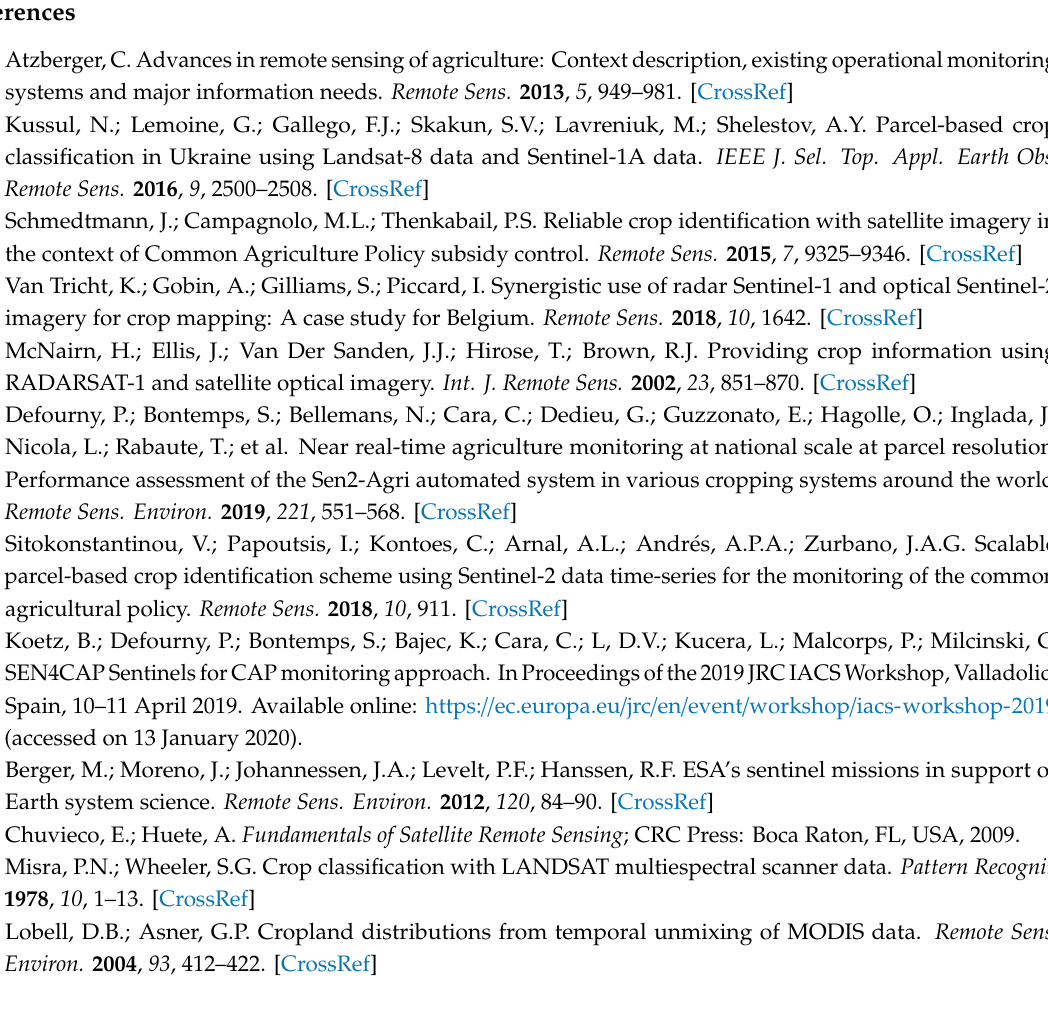
Table S1: Ground truth data. Number of agricultural fields and their area in the declarations and inspections (Regions 1–7). Figure S1. Median temporal signatures of crops for VH, VV and VH / VV (Regions 1–7), Table S2: Confusion matrix of g and R 2 classification for cross-validation (Regions 1–7), Figure S2: F1-score, PA and UA for the di ff erent polarization channels in Cross-validation and External validation (Navarre and Regions 1–7), Figure S3: Overall Accuracy of External validation based on field size: < 0.5 ha (left), 0.5–1 ha (middle) and > 1 ha (right), Figure S4: F1-score, PA and UA of g and R 2 classification based on field size for external validation (Regions